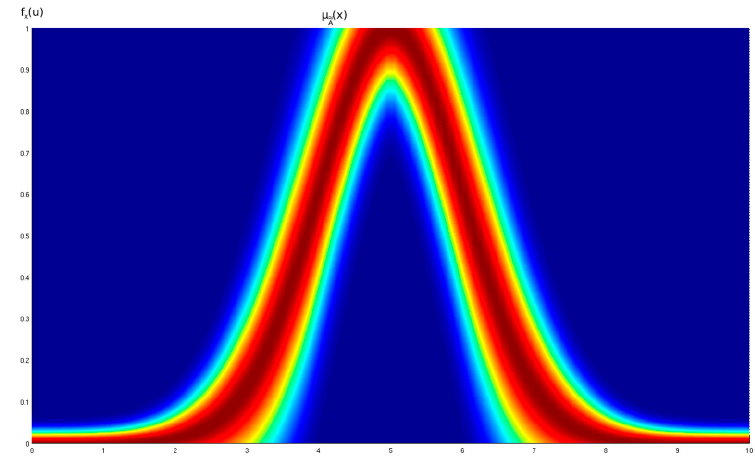
Figure 1. Generic general type-2 fuzzy set (GT2 FS) as shown from the primary function’s perspective.